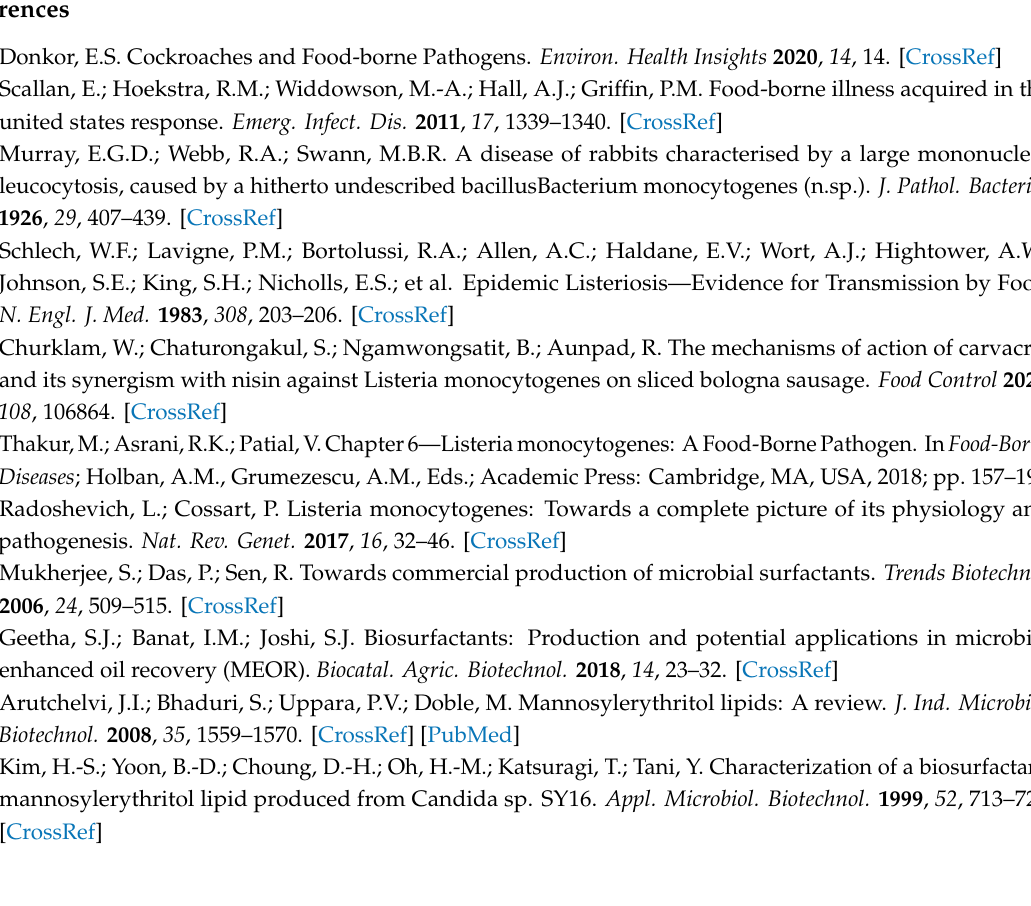
Supplementary Materials: The following are available online. Figure S1: Inhibition e ff ect of di ff erent concentrations of MEL-A on L. monocytogenes and other strains, Table S1: Fold change of major di ff erentially expressed genes in Go enrichment analysis, Table S2: KEGG analysis, Table S3: qRT-PCR validation of RNA-seq